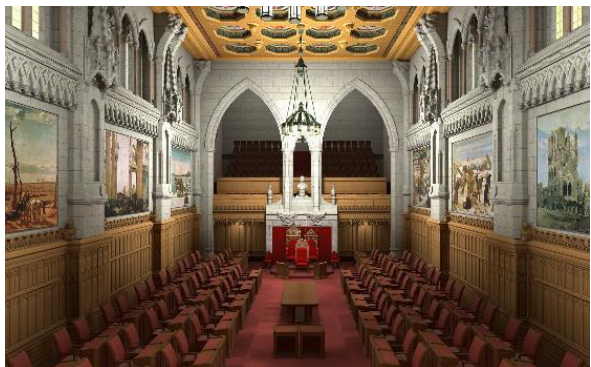
Figure 12. The Senate Chamber viewed in the Unity Editor with baked